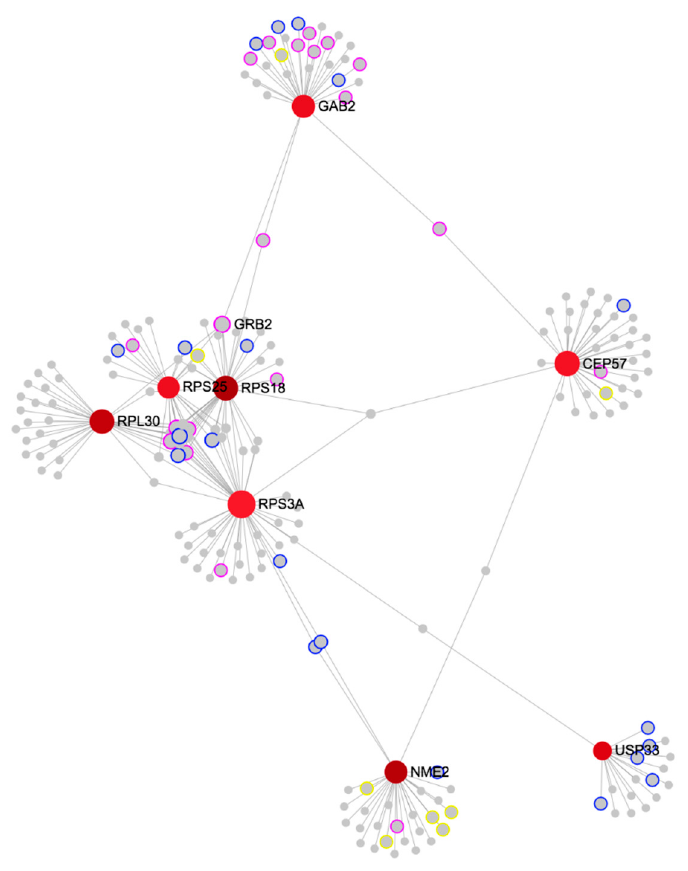
Figure 4. Protein-protein interaction networks of differentially expressed genes associated disease specific survival in mucinous colorectal cancer.